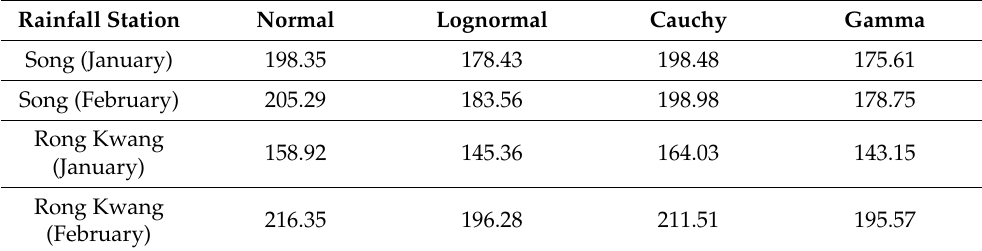
Table 3. AIC results of positive rainfall data.